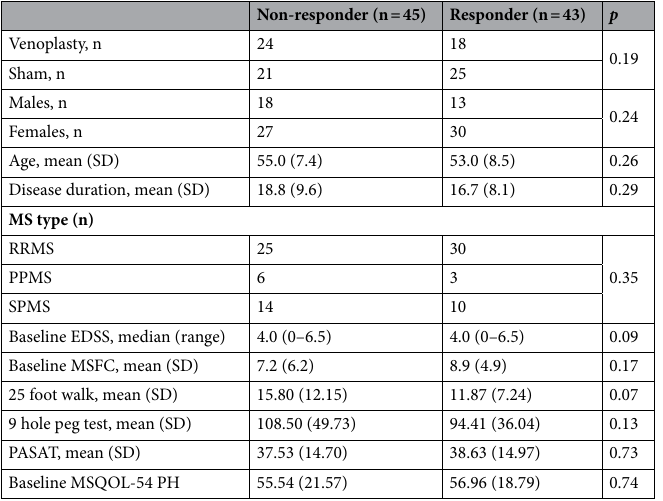
Table 3. Demographic and clinical characteristics of placebo responders and non-responders. RRMS = Remitting relapsing MS; PPMS = primary progressive MS; SPMS = secondary progressive MS; EDSS = expanded disability status scale; MSFC = multiple sclerosis functional composite; PASAT = paced auditory serial addition test; MSQOL-54 PH = multiple sclerosis quality of life-54, physical health composite. For MSFC, raw scores rather than z-scores are